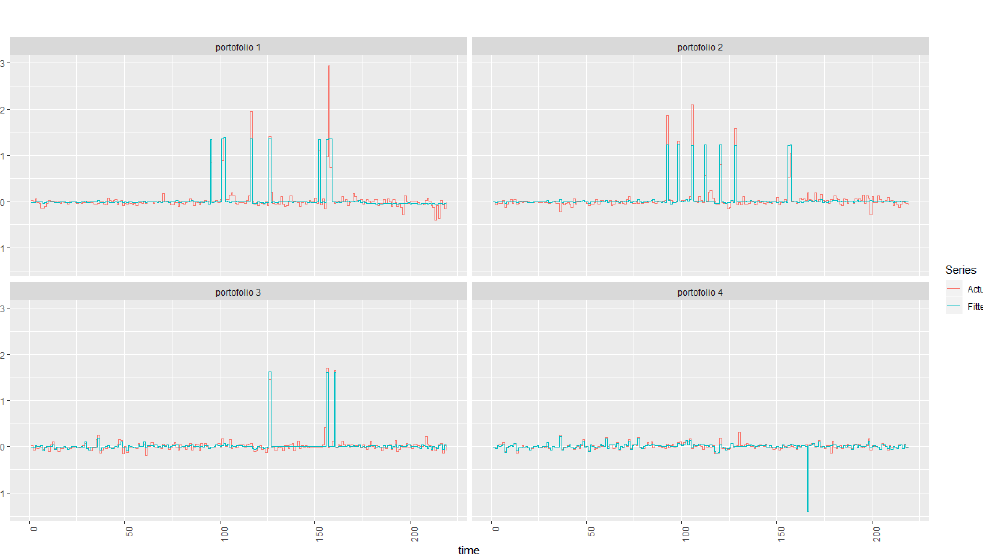
Figure 1. Actual and predicted returns after the one-factor model. Source: author’s